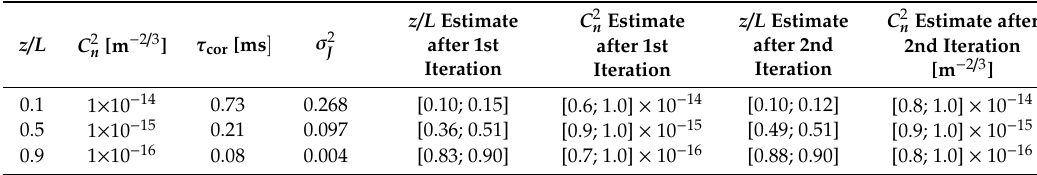
Table 1. Examples of turbulence layer